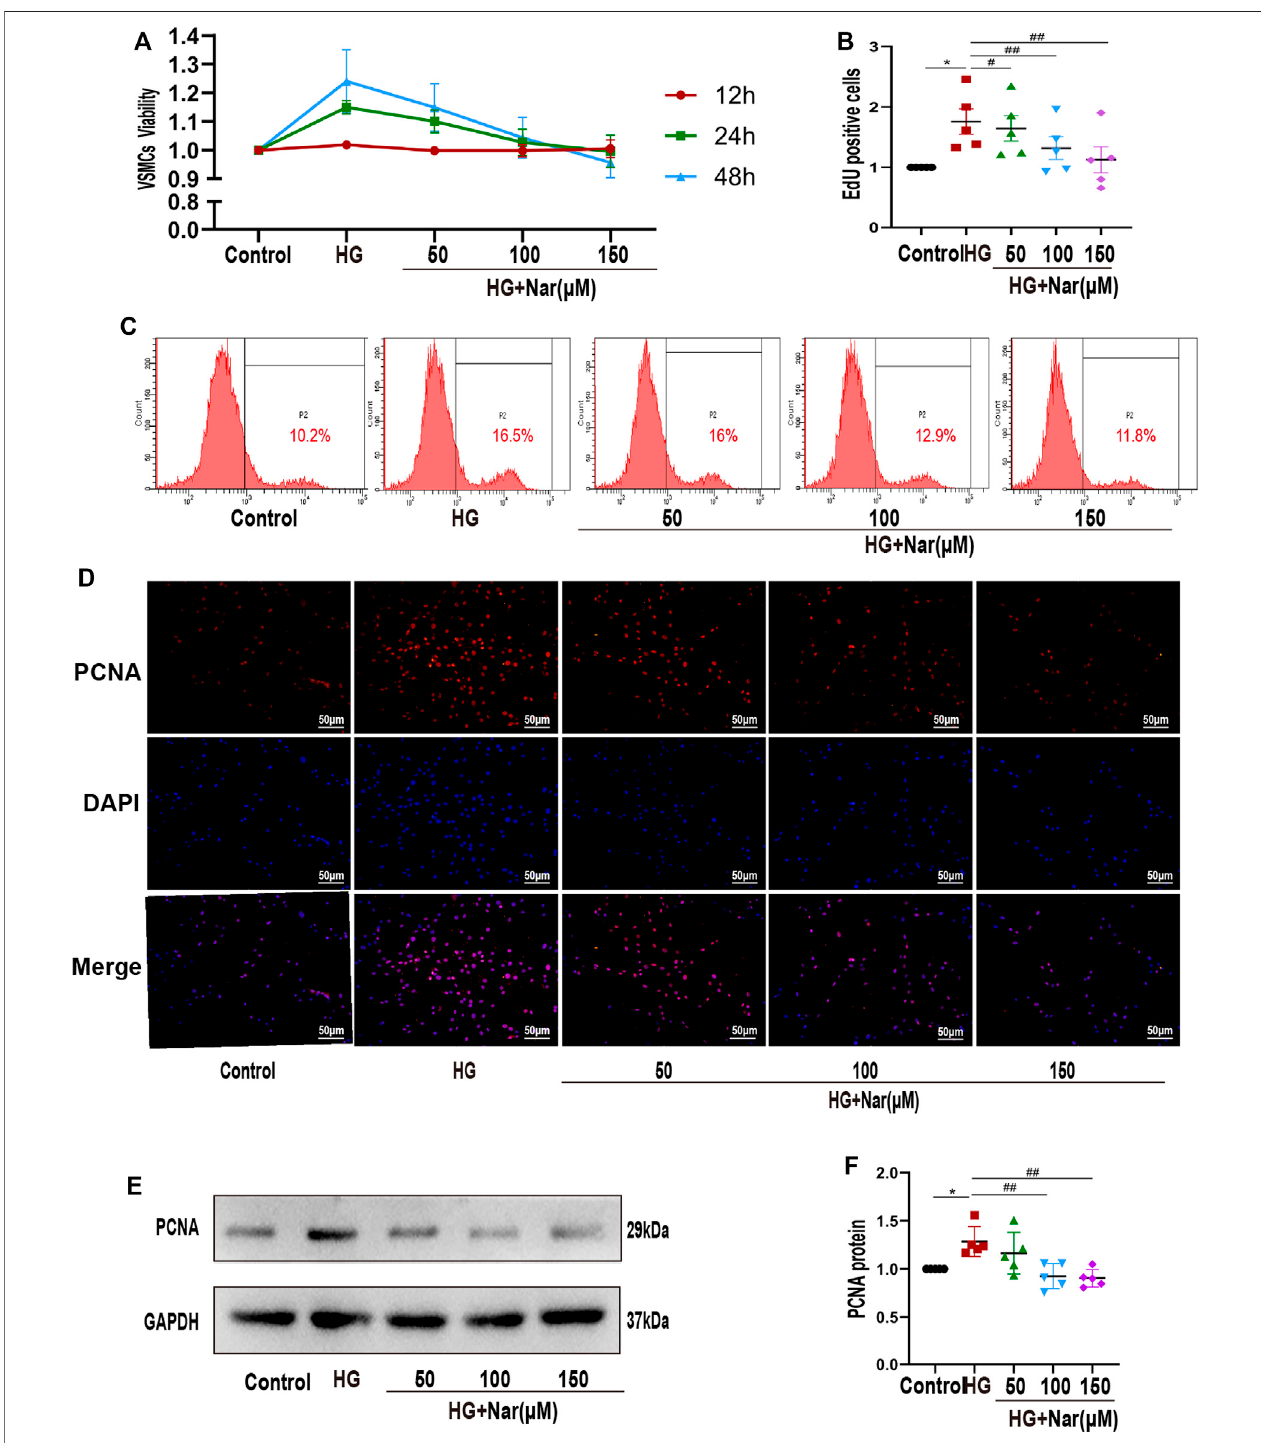
FIGURE3| Nar inhibited high-glucose-induced VSMC proliferation. (A) CCK-8assay showed thatNar reduced theviabilityofhigh-glucose-induced VSMCsat 24 and 48 h, p < 0.05. (B,C) Flow cytometry showed a lower cell proliferation rate in the Nar group than in the HG group. (D) Immuno fl uorescent staining of PCNA (magni fi cation: 200×). (E,F) Western blot analysis showed PCNA expression associated with different treatments of VSMCs, * p < 0.05 compared with Control group, ## p < 0.01 compared with HG group.